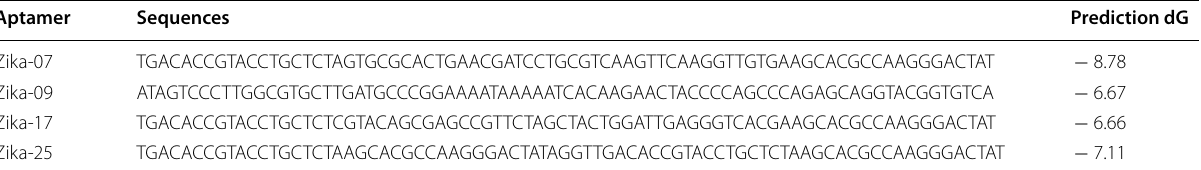
Table 1 List of Zika envelope aptamers screened by SELEX process